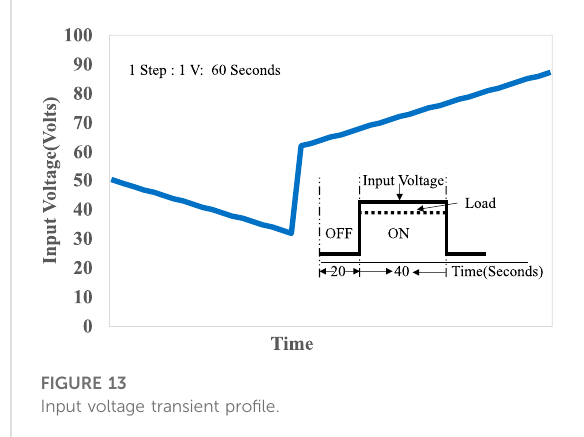
FIGURE 13 Input voltage transient pro fi le.